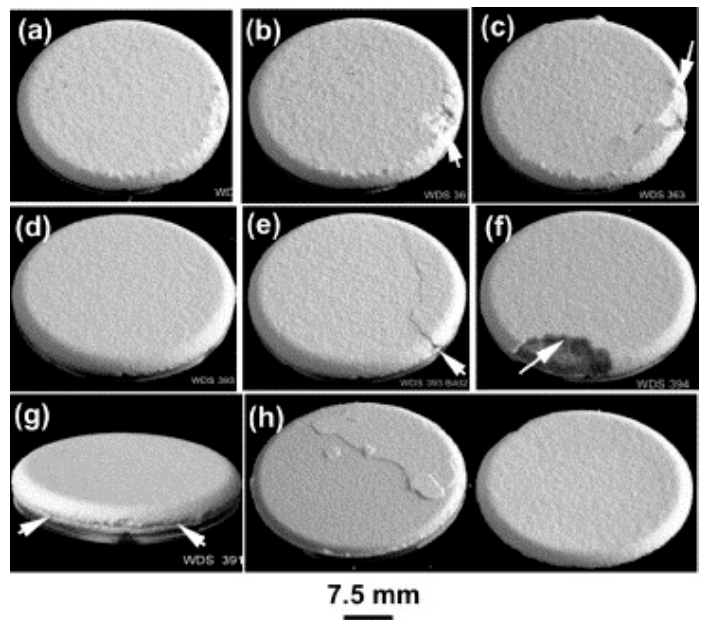
Figure 26. Photographs of TBCs showing coating failure modes: ( a – c ) 2.7 mm − 1 crack density coating cycled to 1238 °C for 1200 cycles and 1770 cycles, and to 1335 °C for 320 cycles, respectively; ( d – f ) 2.7 mm − 1 crack density coating cycled to 1226 °C for 1650 cycles and 1810 cycles, and to 1317 °C for 174 cycles, respectively; ( g , h ) 0.9 mm − 1 crack density coating cycled to 1216 °C for 1071 cycles and to 1327 °C for 217 cycles, respectively [118] .